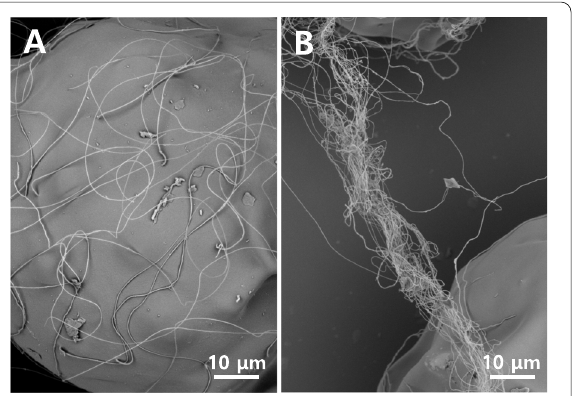
Fig. 2 Scanning electron micrographs of the outer surface of fertilized egg envelope. The outer surface was smooth and the adhesive filaments are distributed around the egg envelope ( A ). Each adhesive filament was joined together to form a long bundle ( B )